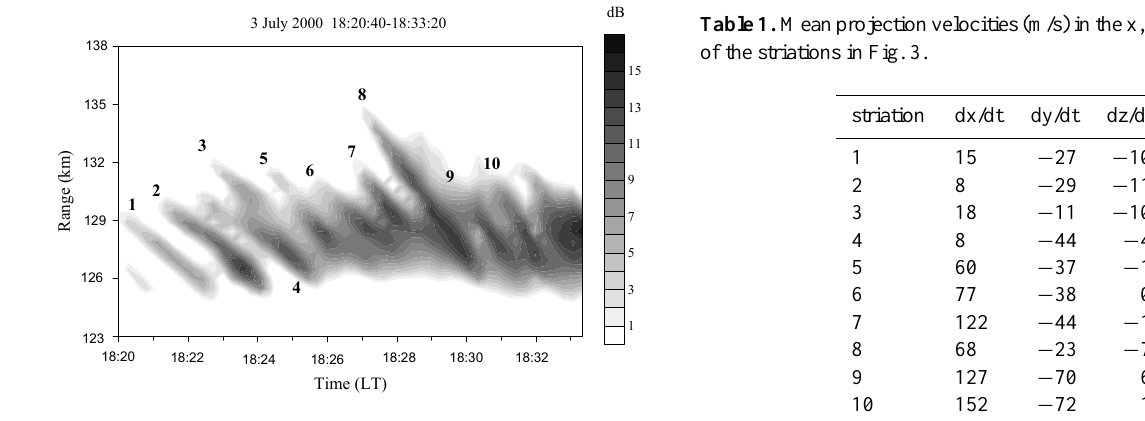
Fig. 3 Fig. 3. Range-time-intensity plot of QP echoes observed with the Chung-Li VHF radar between 18:20 to 18:33 LT on 3 July 2000.